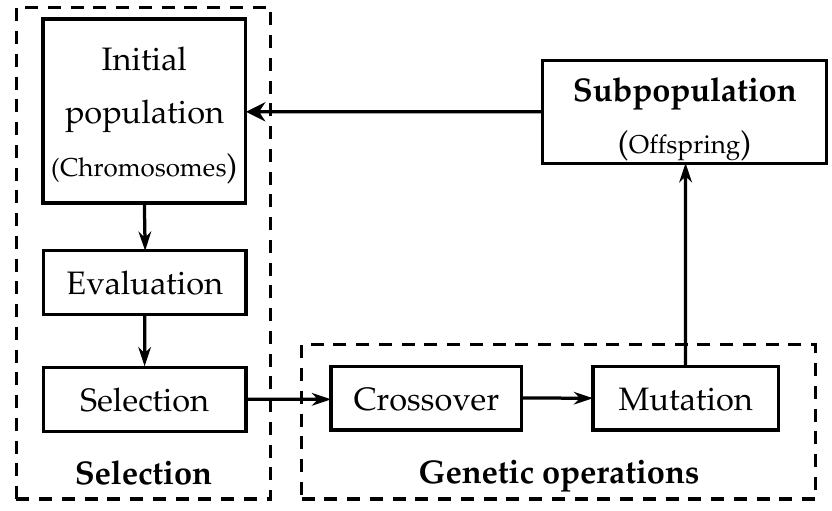
Figure 8. The schema of the genetic algorithm cycle.